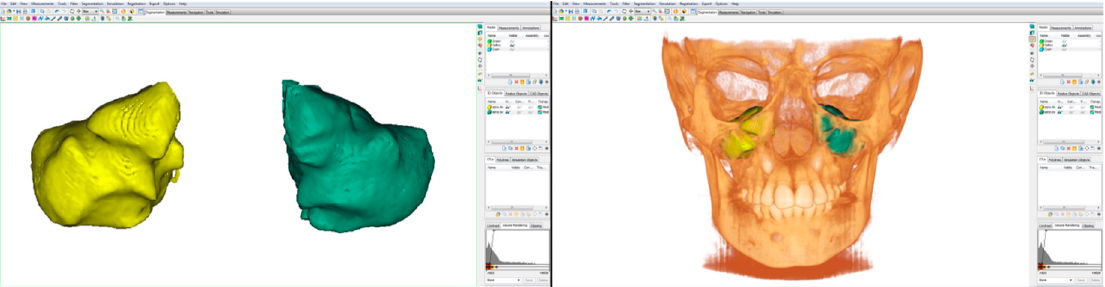
Figure 3. Three-dimensional image of the right and left maxillary sinuses.